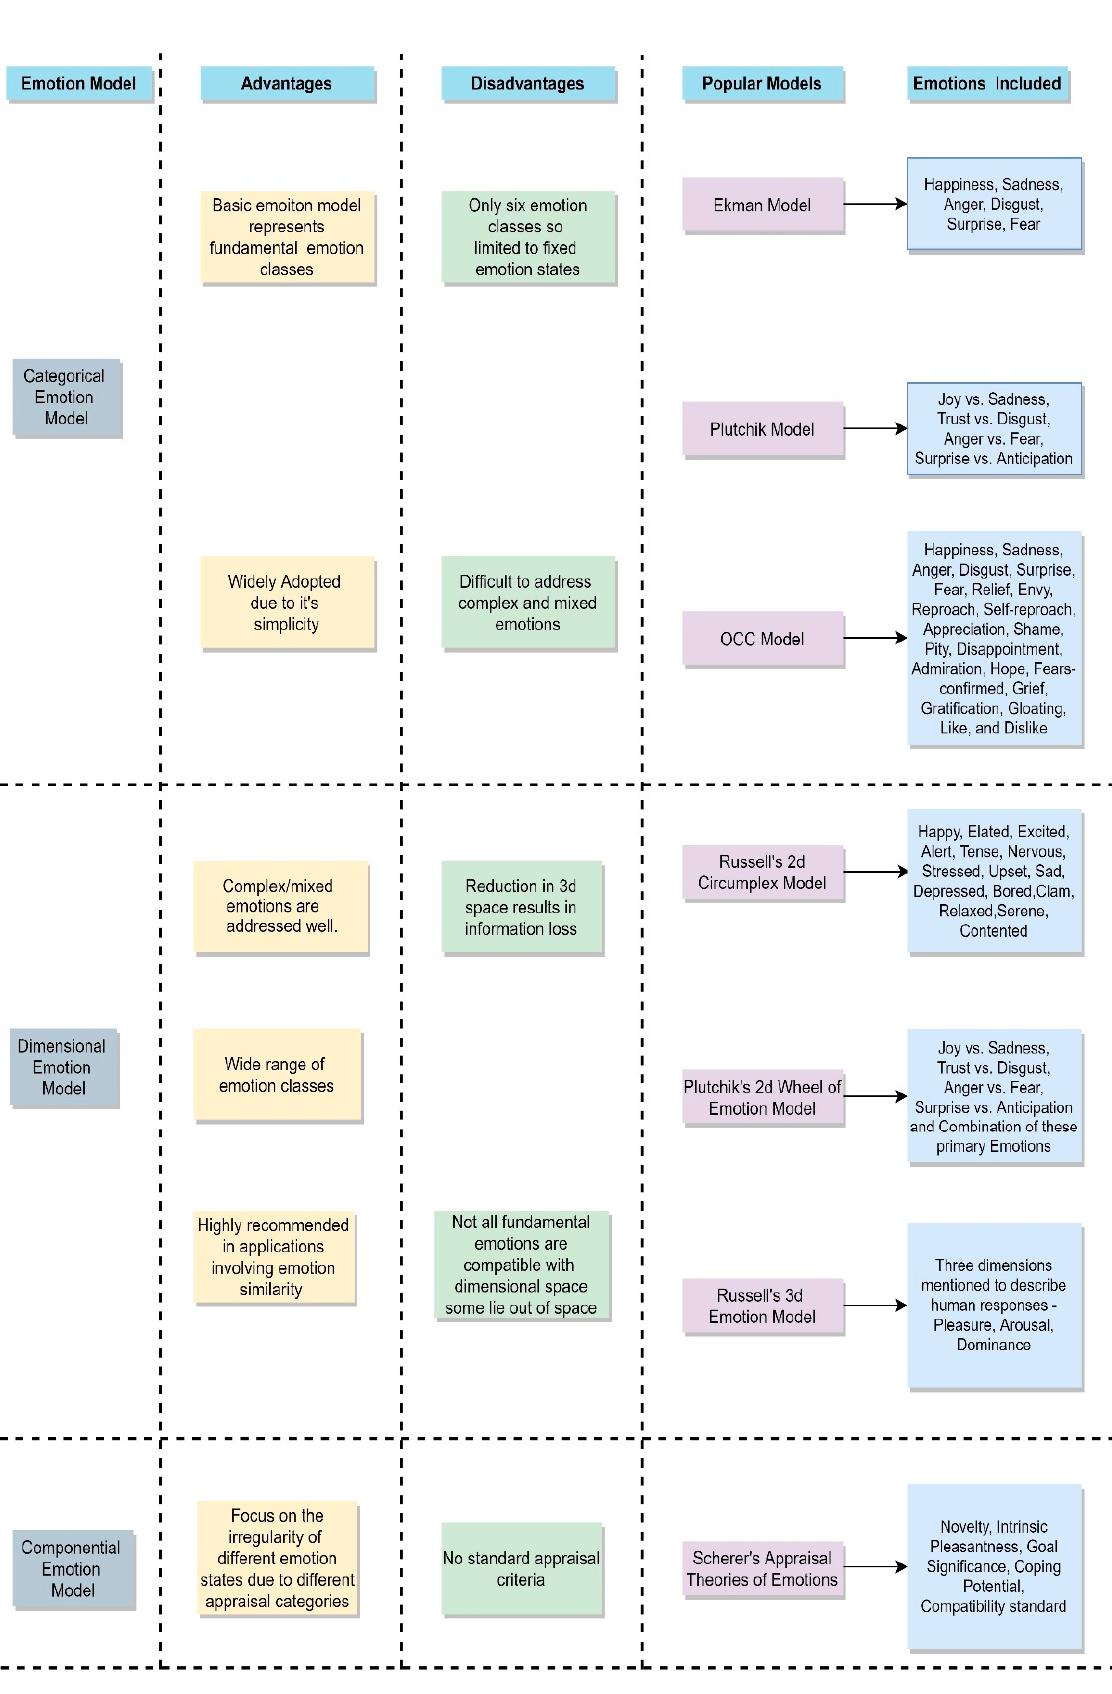
Figure 2. Comparative analysis of different emotion models.